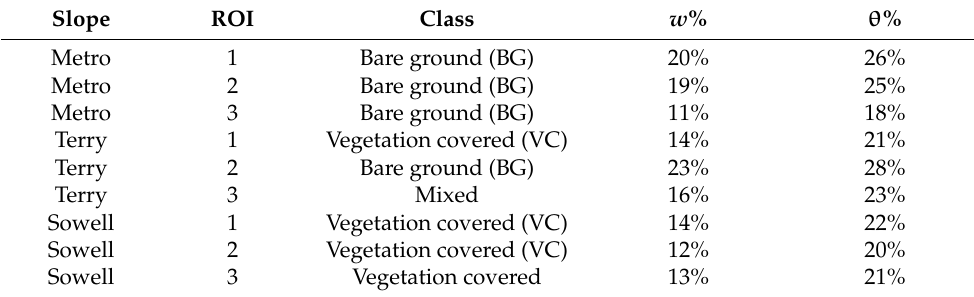
Table 1. Ground truth soil moisture content.